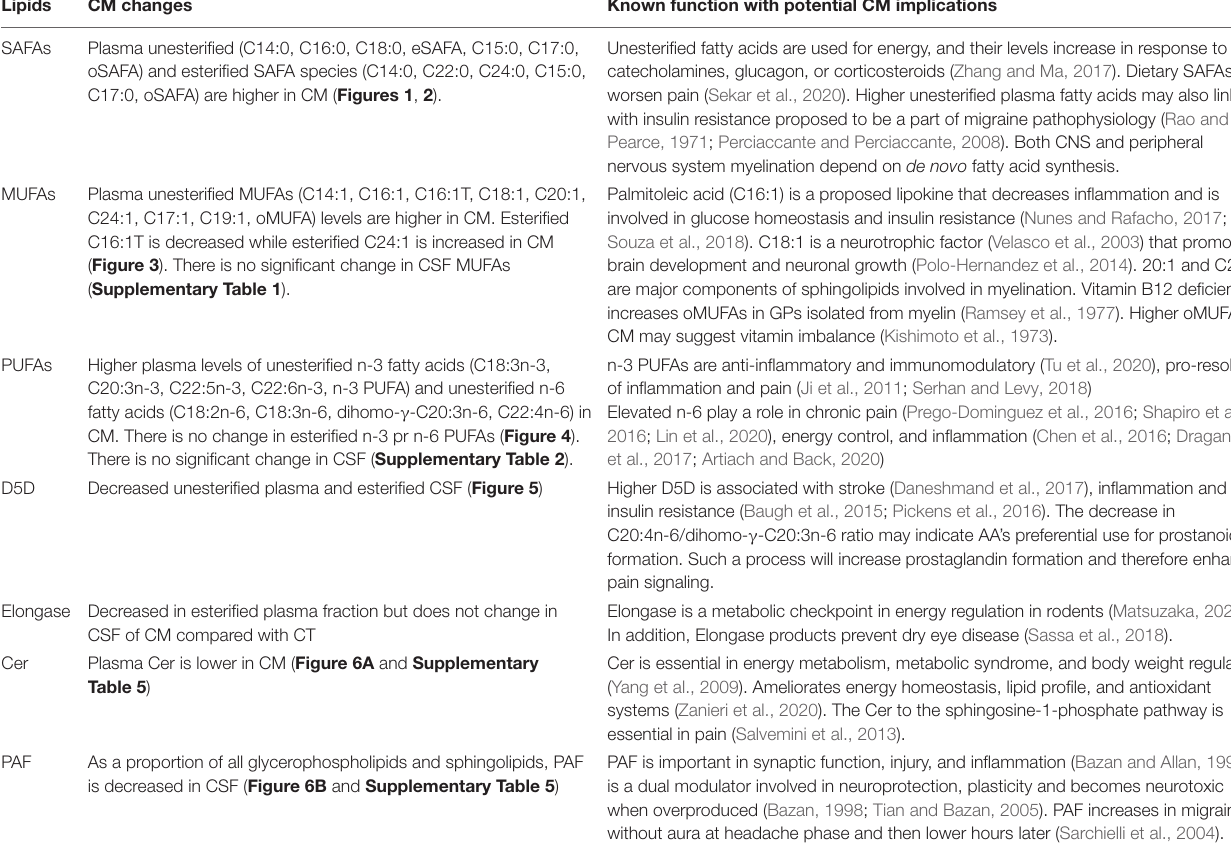
TABLE 2 | Summary of lipid changes in CM and possible implications. Lipids CM changes Known function with potential CM implications